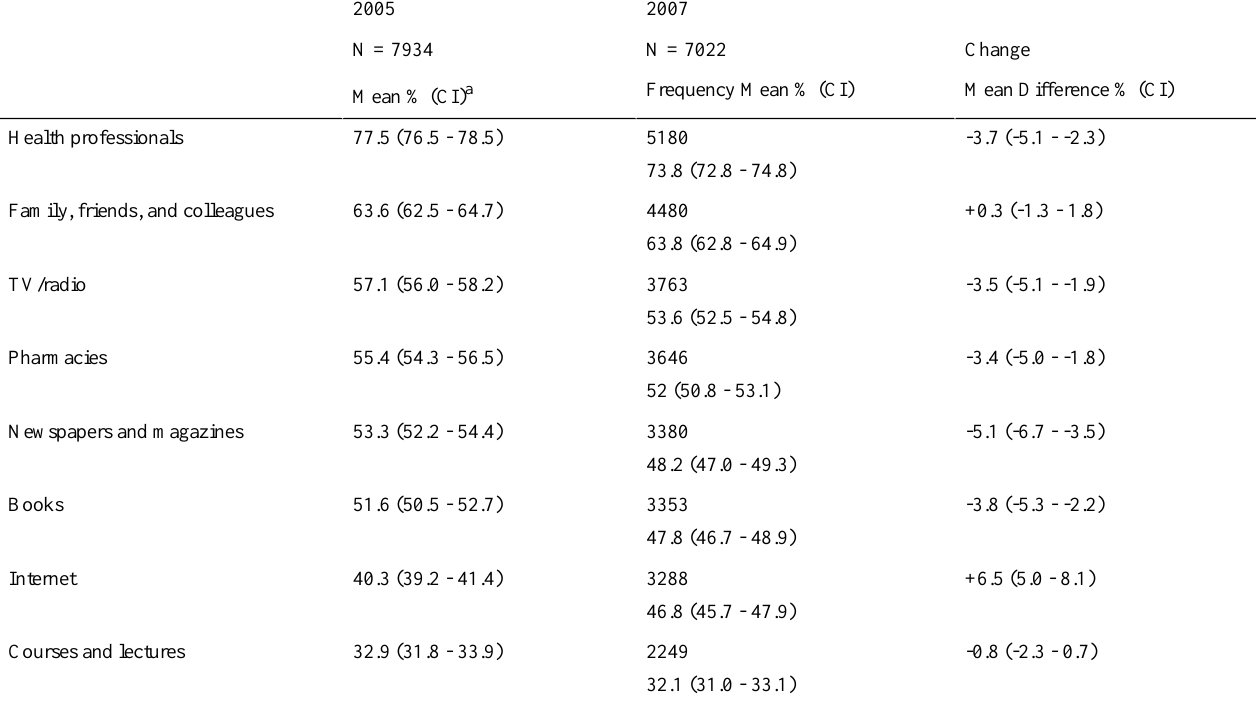
Table 2. Importance of various sources for health